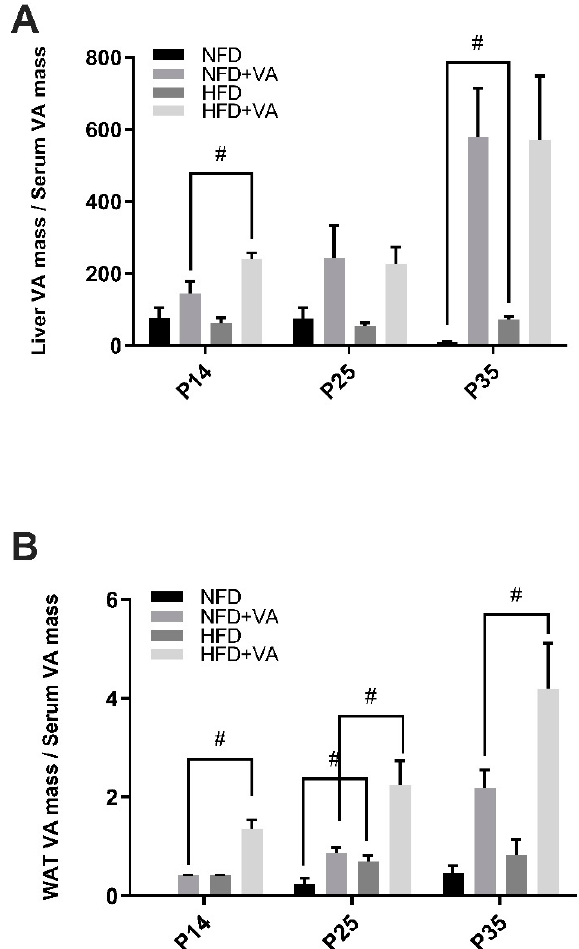
Figure 4. Ratio of total retinol mass in the liver to in serum ( A ), and that in white adipose tissue to in serum ( B ). Bars show mean ± SEM, n = 4 or 3 per group. Significant di ff erence, p < 0.05, between NFD and HFD or between NFD + VA and HFD + VA by #. P14, postnatal day 14; P25, postnatal day 25; P35, postnatal day 35; NFD, normal fat diet; HFD, high fat diet; VA, vitamin A. Note: At P14, white adipose tissue samples in the NFD group were not adequate for analysis, and therefore data are missing.